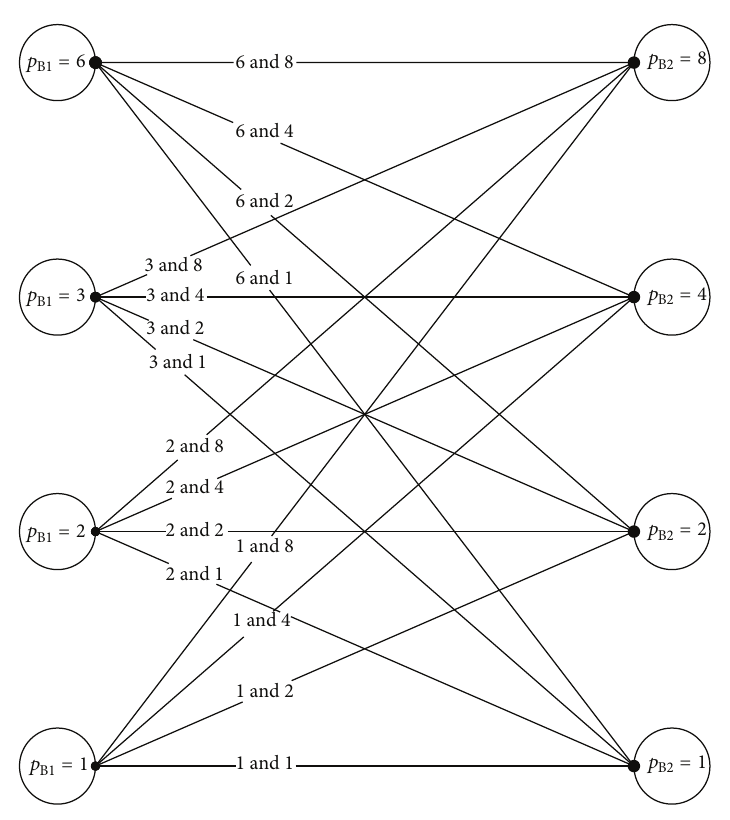
Figure 7: In total, there are sixteen possible configurations for flux distribution B using nodes method. Table 2: Comparison of different array configurations at DNI: 641W/m 2